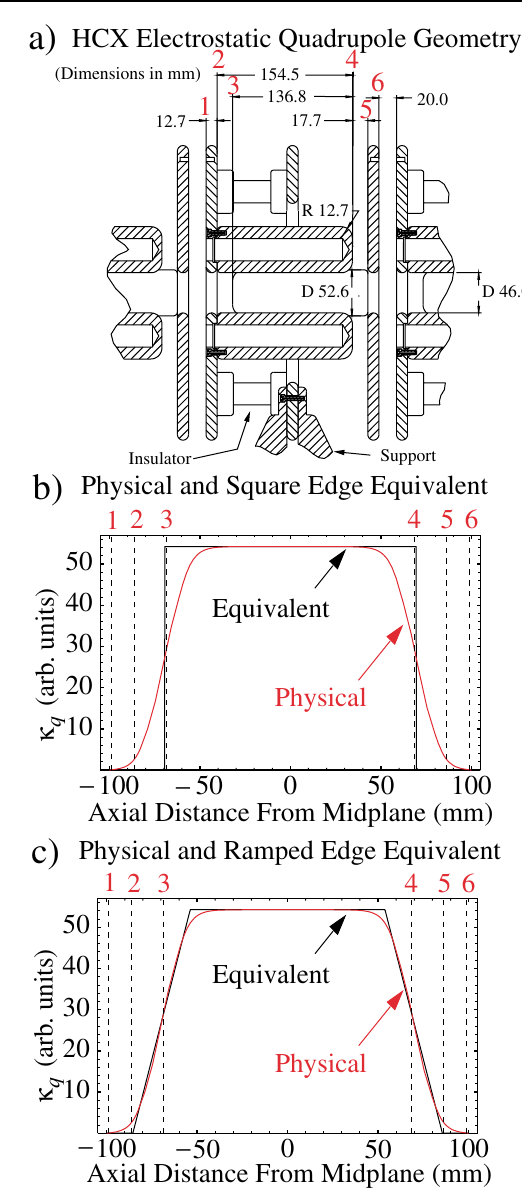
FIG. 22. (Color) Transverse cross section (a) of the electro- static quadrupole lattice geometry of the HCX. In (b) and (c), (cid:3) s (cid:4) are plotted in arbitrary corresponding focusing functions (cid:11) q units versus axial distance from the axial midplane of the (cid:3) s (cid:4) is shown (red) together quadrupole. The physical lattice (cid:11) q (cid:3) s (cid:4) for equivalent fringe models with square and with (cid:11) q ramped edges (black) in (b) and (c). Dotted lines in (b) and (c) indicate axial locations of structures shown in (a) with labels 1–6 in